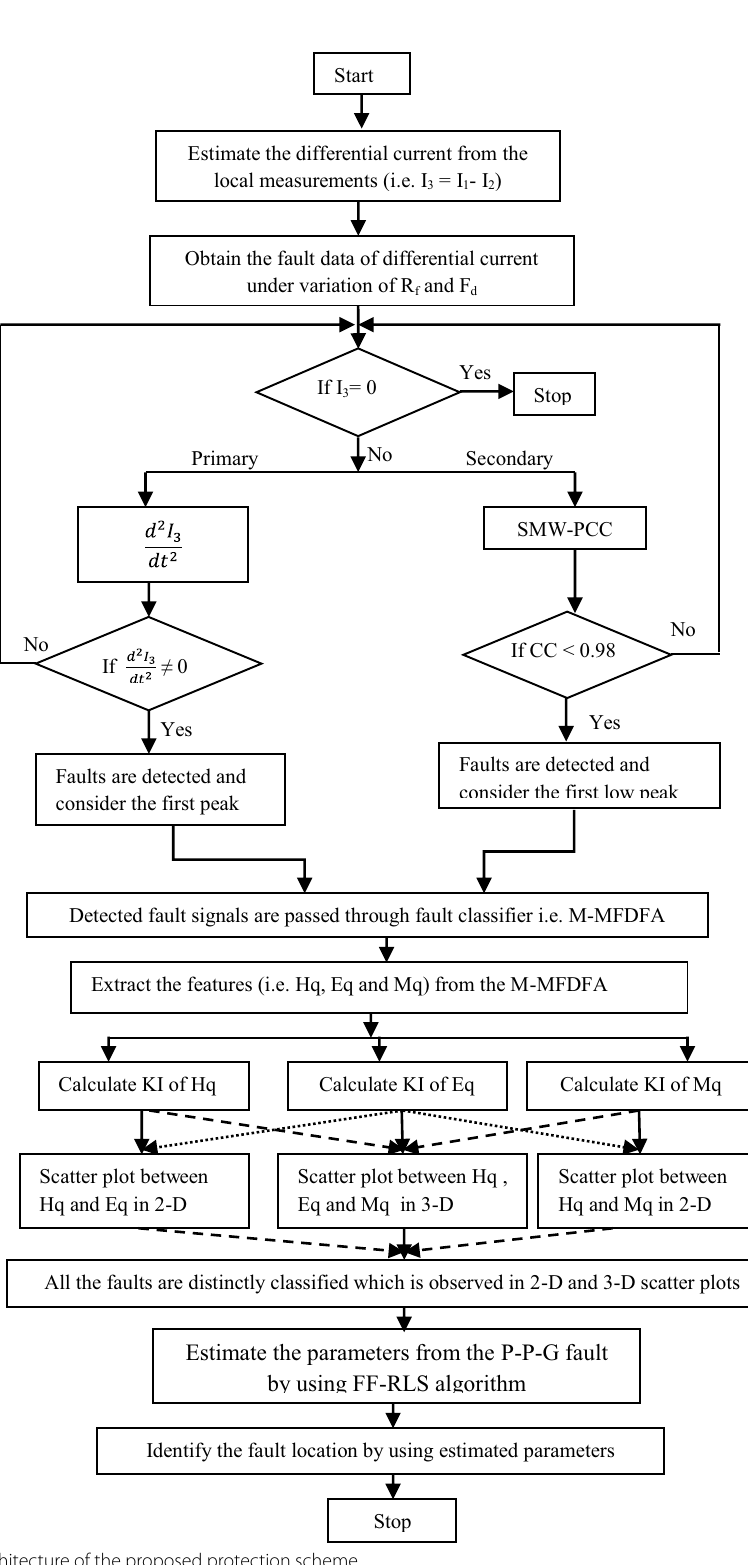
Fig. 1 The complete architecture of the proposed protection